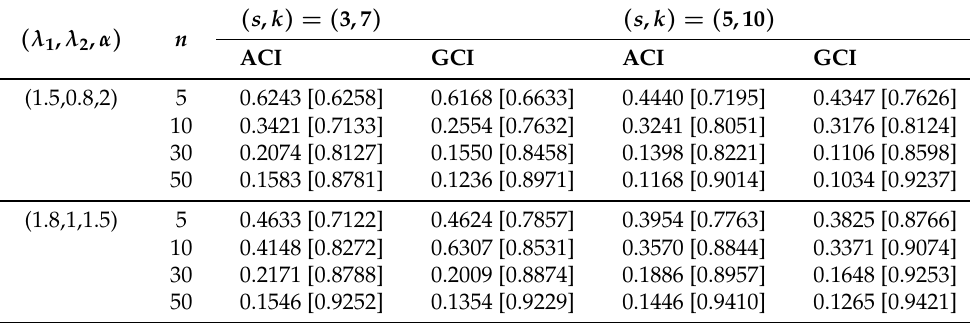
Table 2. AWs and CPs (within bracket) for R s , k with common parameters.